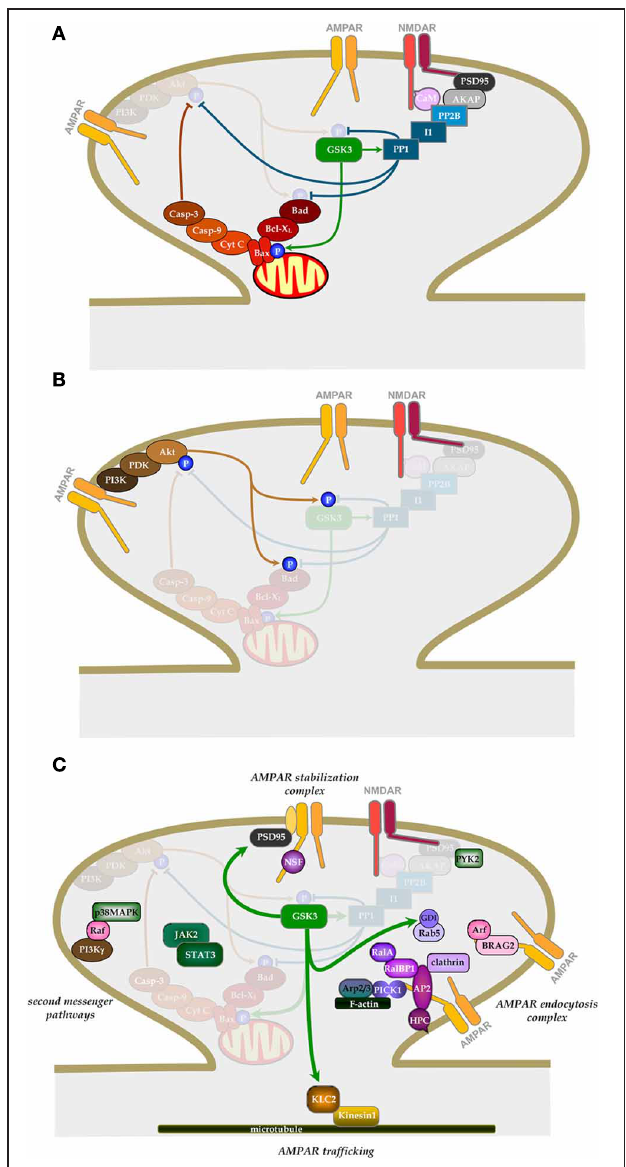
FIGURE 2 | The role of GSK-3 in NMDAR-LTD. (A) Signaling pathways involved in the induction of NMDAR-LTD and the regulation of GSK-3 β . (B) Signaling pathway by which NMDAR-LTP can inhibit NMDAR-LTD. (C) Potential downstream effectors of GSK-3 β in NMDAR-LTD. (See text for